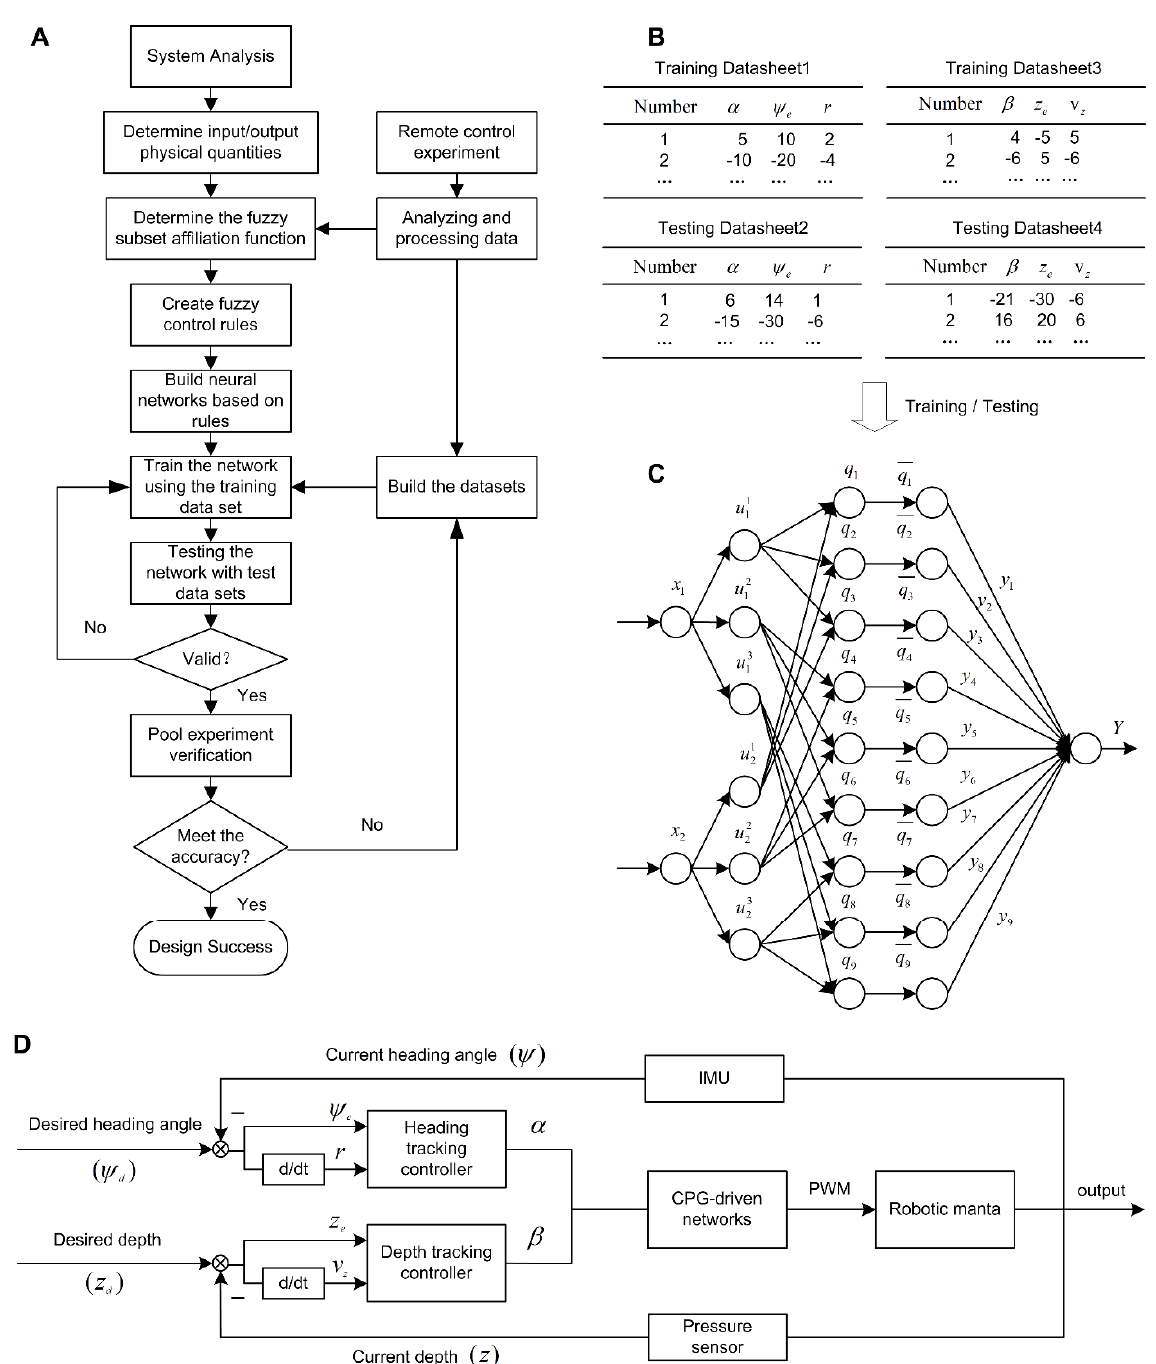
Figure 5. The methods of CPG and T ‐ S Fuzzy neural network ‐ based Control of a Robotic Manta for depth and heading tracking. ( A ) The flow chart of controller design. ( B ) Schematic diagram of the datasets. ( C ) T ‐ S fuzzy neural network structure diagram. ( D ) The control structure of the robotic manta.